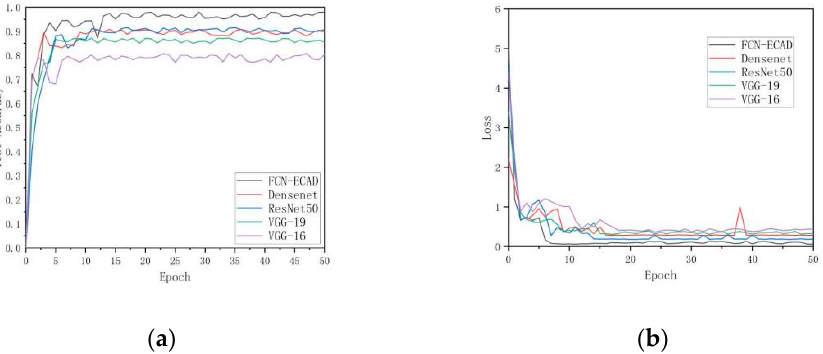
Figure 10. Recognition accuracy and loss curves of the comparison models: ( a ) model test accuracy comparison and ( b ) model loss comparison.